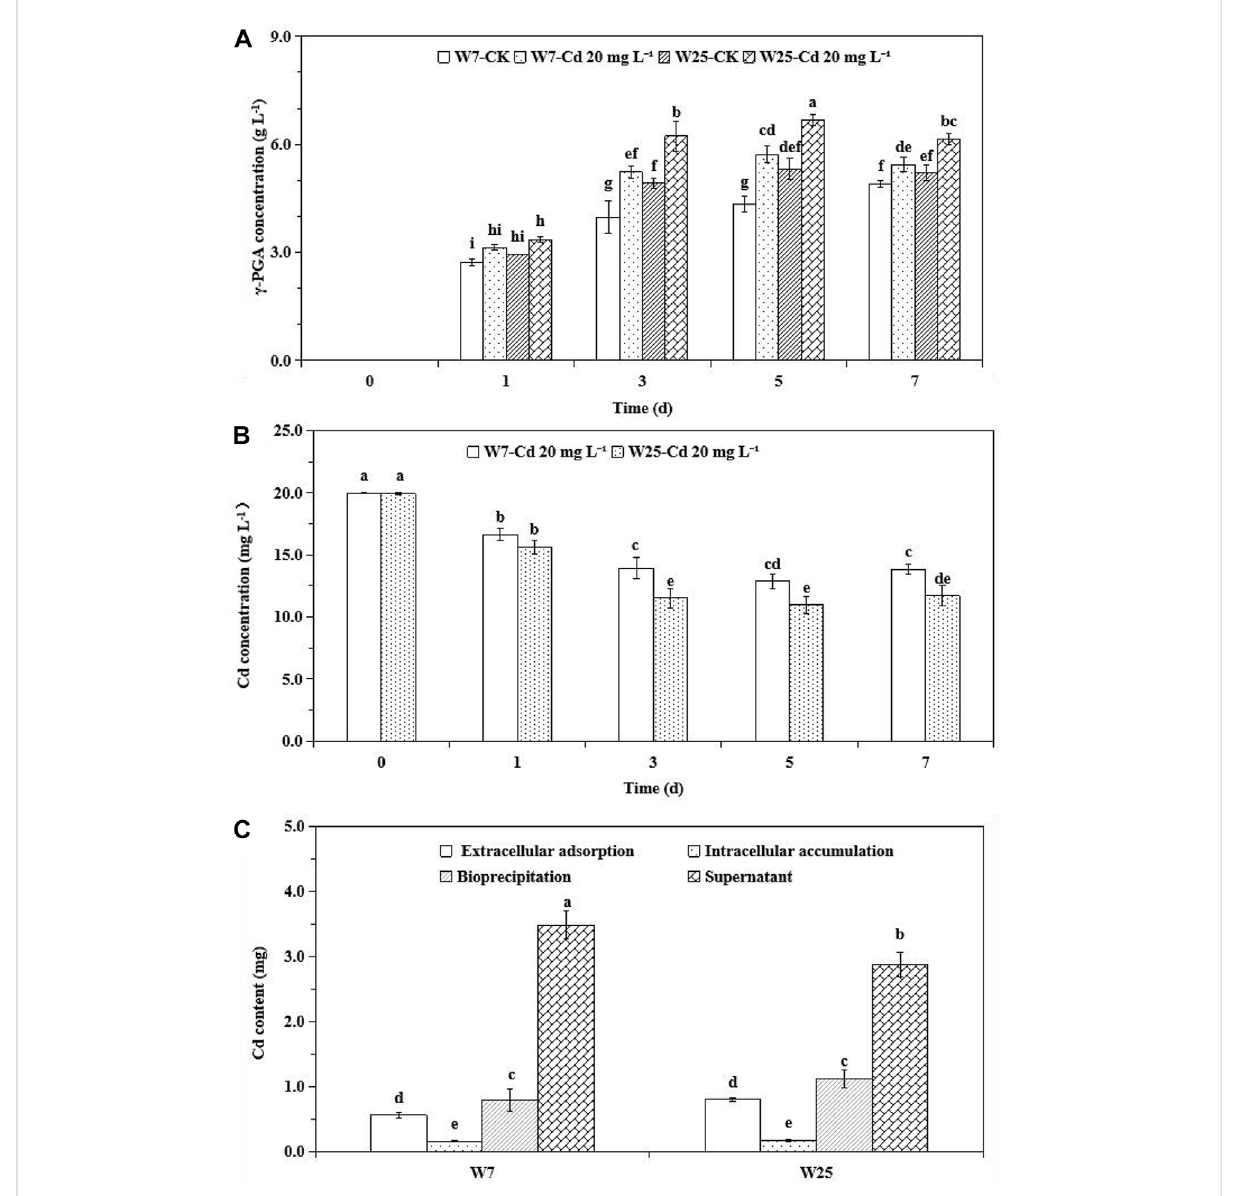
FIGURE 1 γ -PGA (A) and Cd concentration (B) in the culture solution inoculated with strains W7 and W25 and extracellular adsorption, intracellular accumulation, and bioprecipitation of Cd by strains W7 and W25 (C) . Error bars are mean ± standard error ( n = 3). Bars with the same letter are not signi fi cantly different ( p > 0.05) according to Tukey ’ s